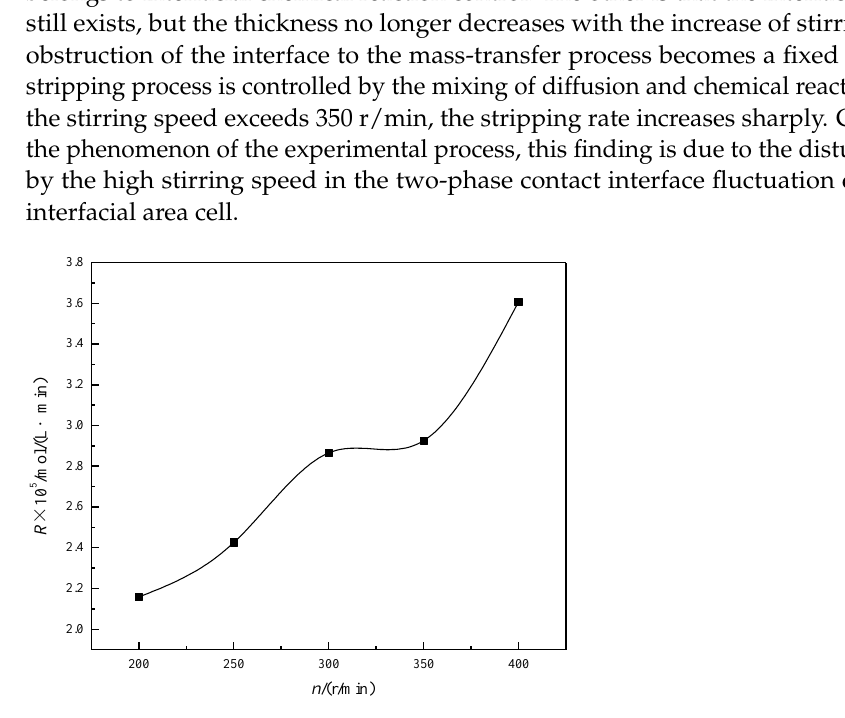
Figure 2. Effect of stirring speed on the stripping rate (experimental conditions: HEH/EHP concen- tration 0.2 mol/L, Ce 4+ concentration in organic phase 0.02 mol/L, HCl concentration in stripping agent 6.0 mol/L, c (H 2 O 2 ) (a) : c (Ce) (o) 2:1, and temperature 25 °C).